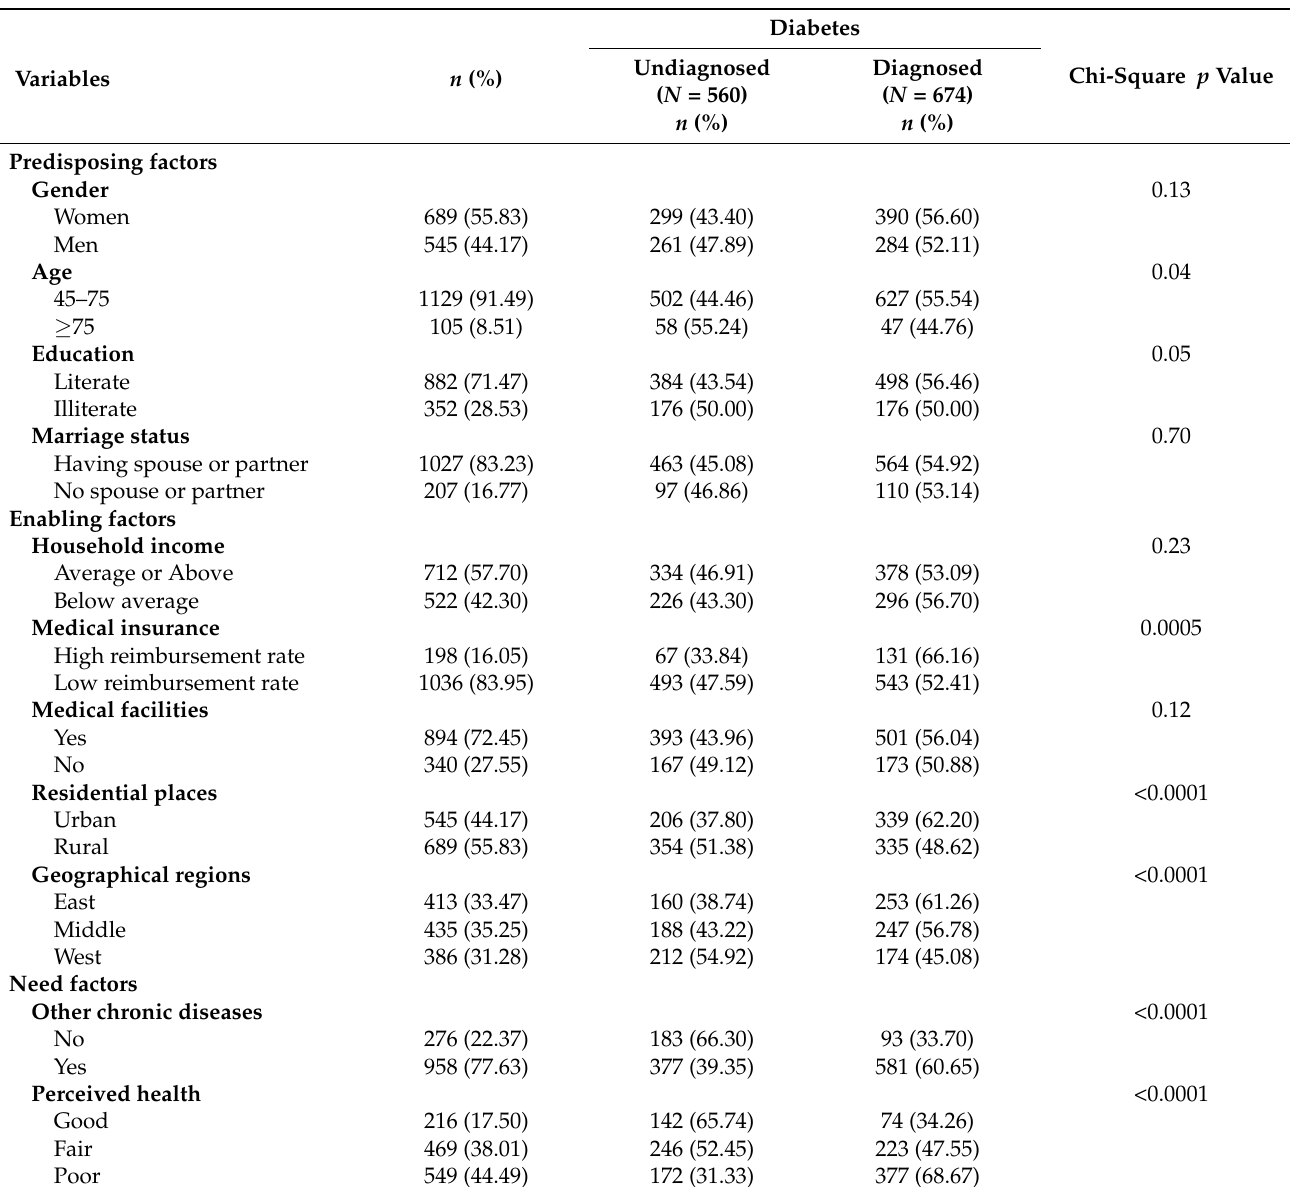
Table 1. Univariate analysis of variables associated with diabetes